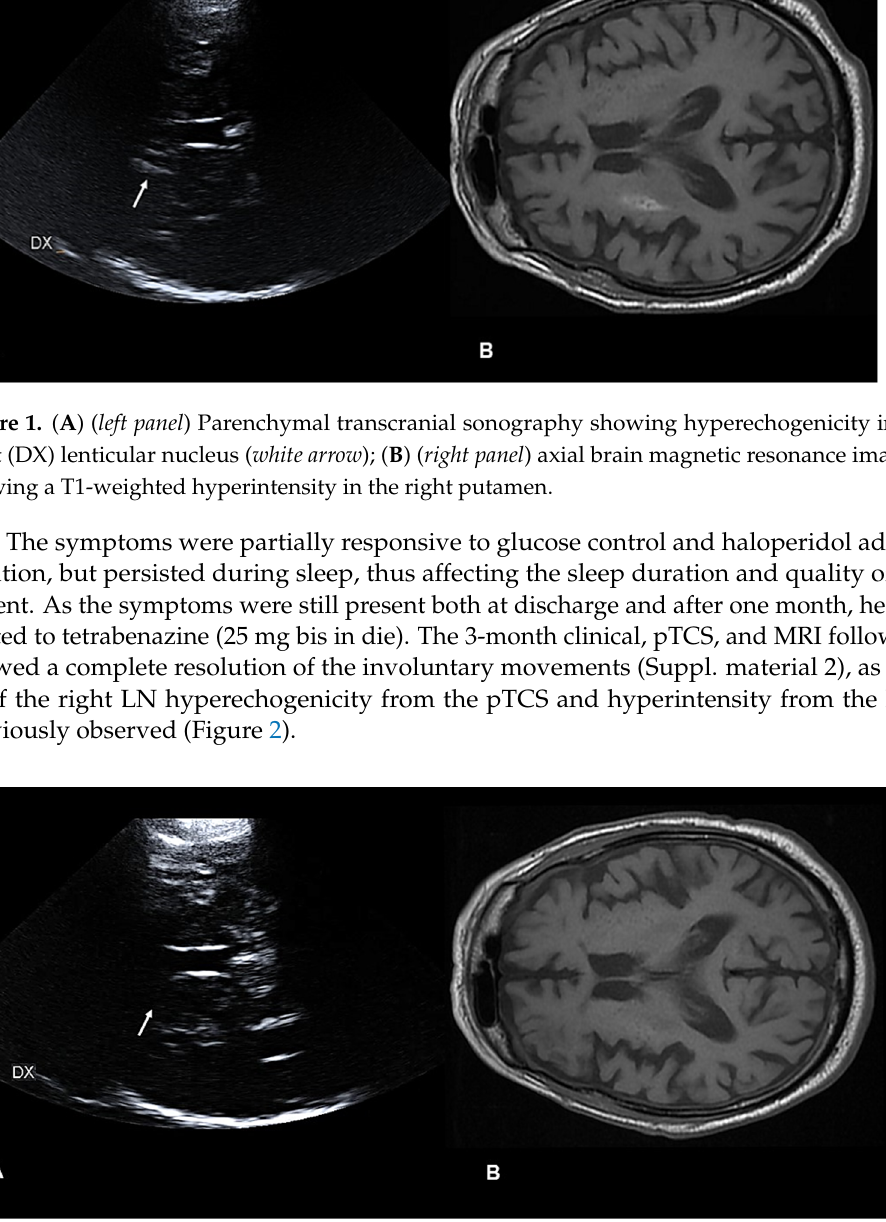
Figure 2. ( A ) ( left panel ) Parenchymal transcranial sonography showing the complete resolution of the hyperechogenicity in the right (DX) lenticular nucleus previously observed ( white arrow ); ( B ) ( right panel ) axial brain magnetic resonance imaging showing normal T1-weighted intensity in the right putamen.